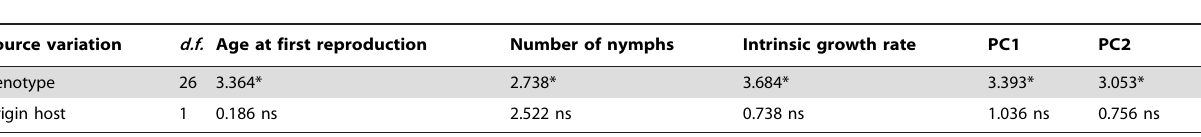
Table 3. Statistics F from analysis of variance of plasticity index of life history traits of 27 genotypes of Brevicoryne brassicae collected and grown on B. campestris and B. oleracea